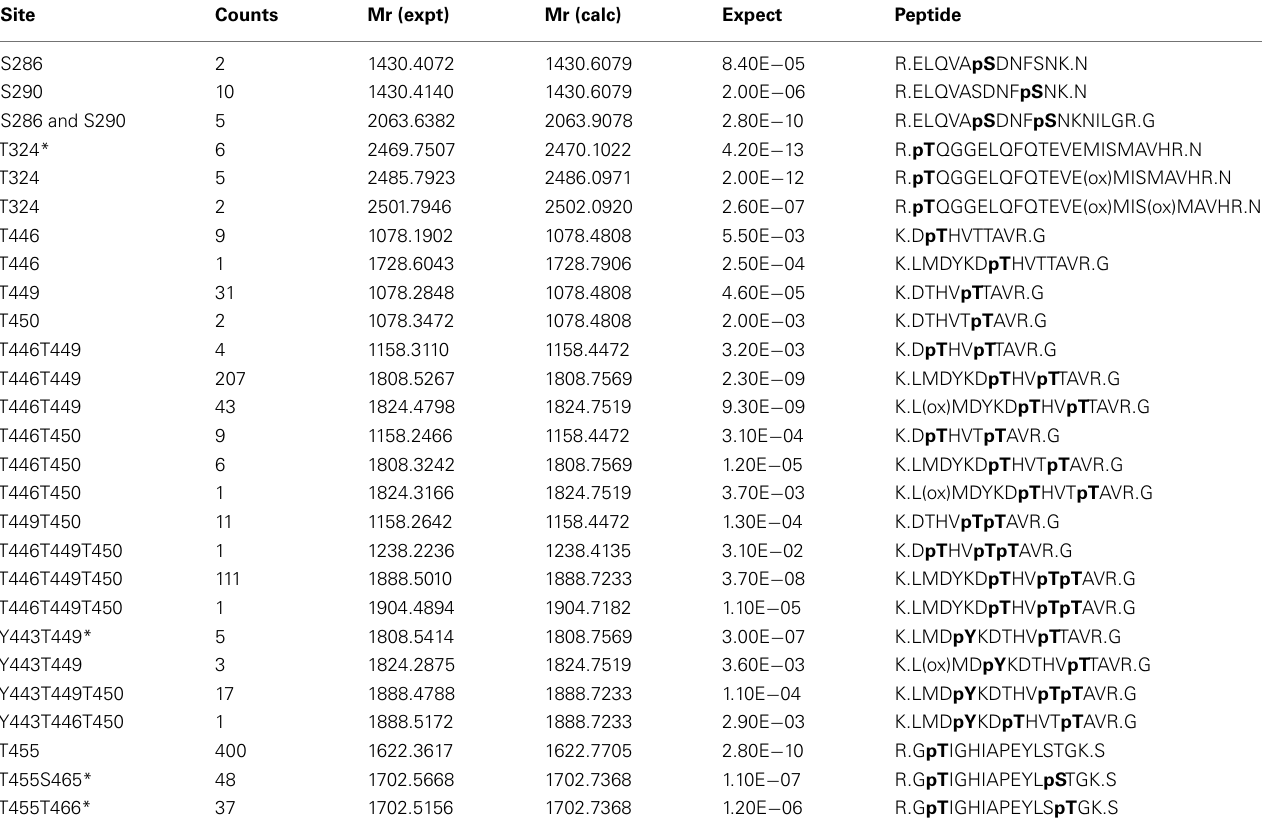
Table 2 | Identified autophosphorylation sites of Flag-BAK1 expressed in E.coli .